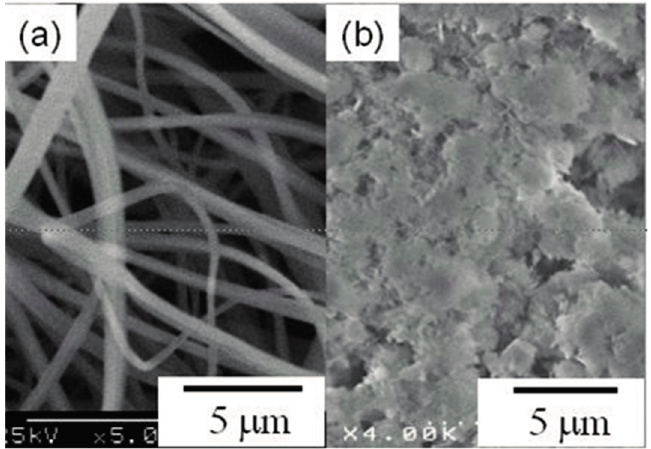
Figure 4. ( a ) Scanning electron microscopy of a Cellulose-copoly [Ser(PO 3 H 2 ) x , Asp y ]- Composite-ESNW ( x : y = 75:25) (1.0 wt % towards cellulose); ( b ) Morphology